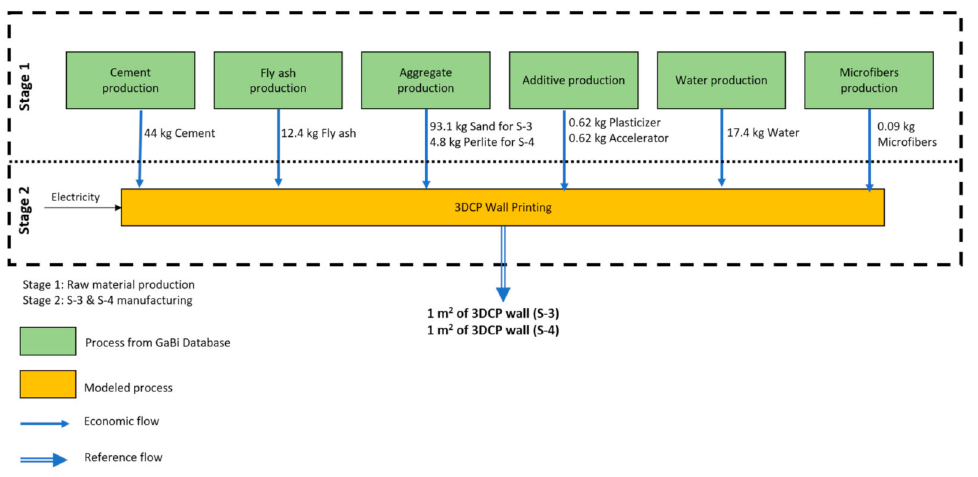
Figure 7. Flowchart of S-3 and